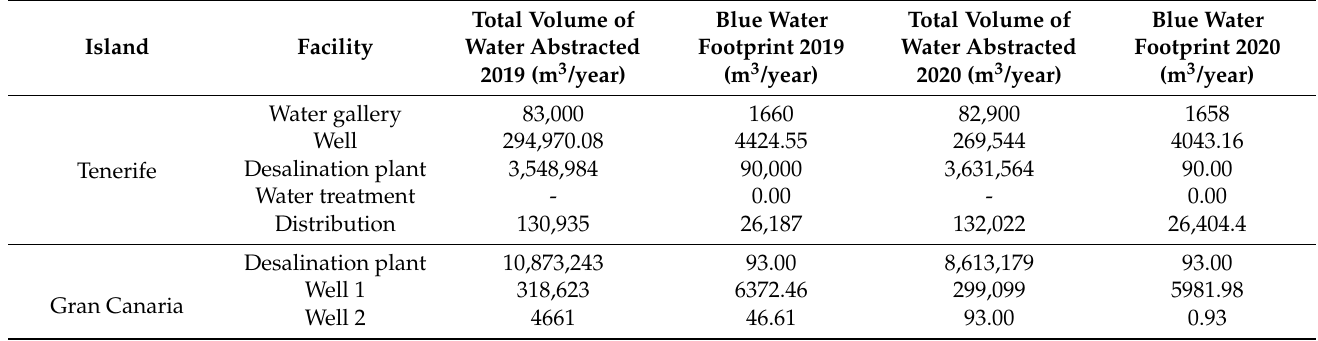
Table 1. Results of the total volume of water abstracted and blue water footprint at the eight facilities studied in the Canary Islands during the years 2019 and